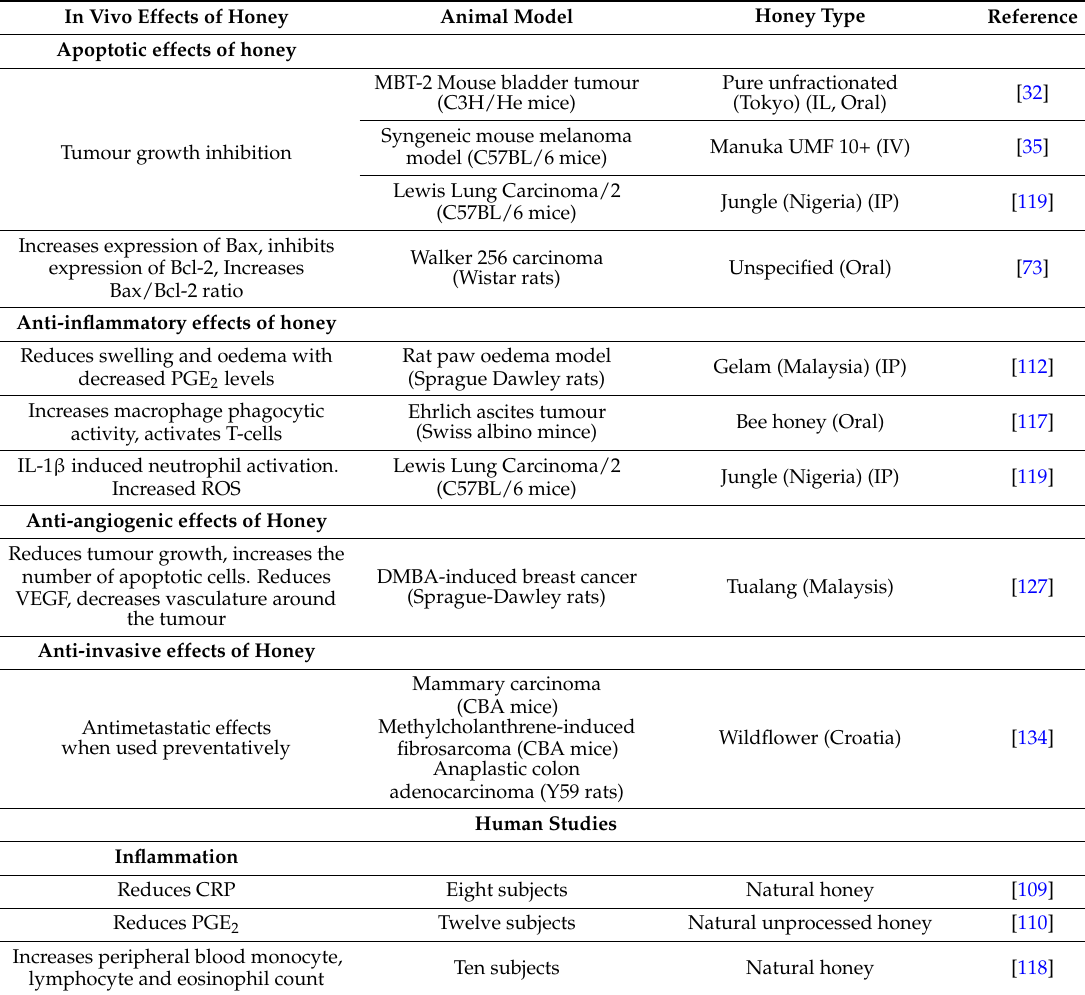
Table 2. The in vivo effects of a variety of hone types on a range of cancer models, including human studies investigating the effects of honey on biomarkers of